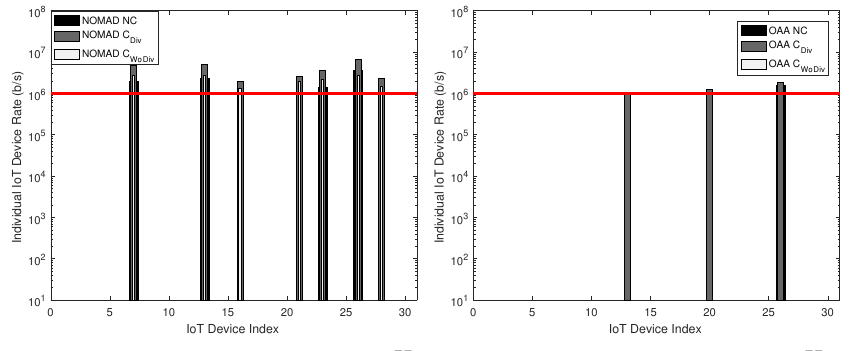
( b ) OAA with K = 30, R = 5, Objective f EE Γ